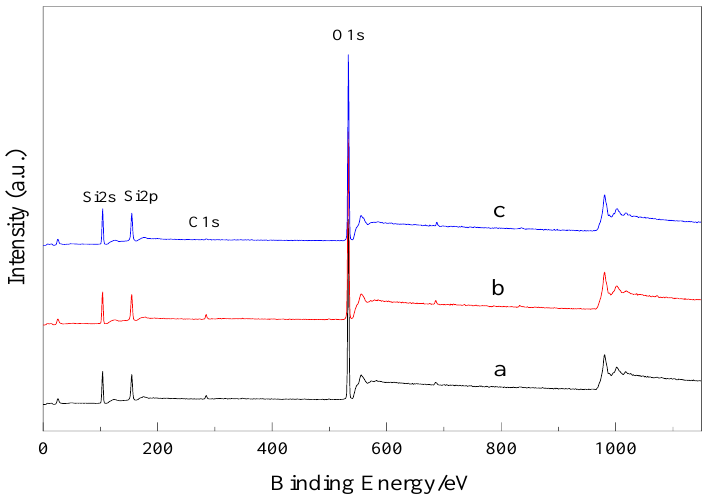
Figure 5. X-ray photoelectron spectroscopy for the samples. a -Mesoporous material synthesized with Gemini ionic liquid surfactant [N 1116 C 3 IMC 16 ][Br] 2 as template. b -Mesoporous material syn- thesized with Gemini ionic liquid surfactant [N 1116 C 3 N 1116 ][Br] 2 as template. c -Mesoporous material synthesized with Gemini ionic liquid surfactant [C 16 IMC 3 C 16 IM][Br] 2 as template. Table 2. XPS element analysis results of samples.